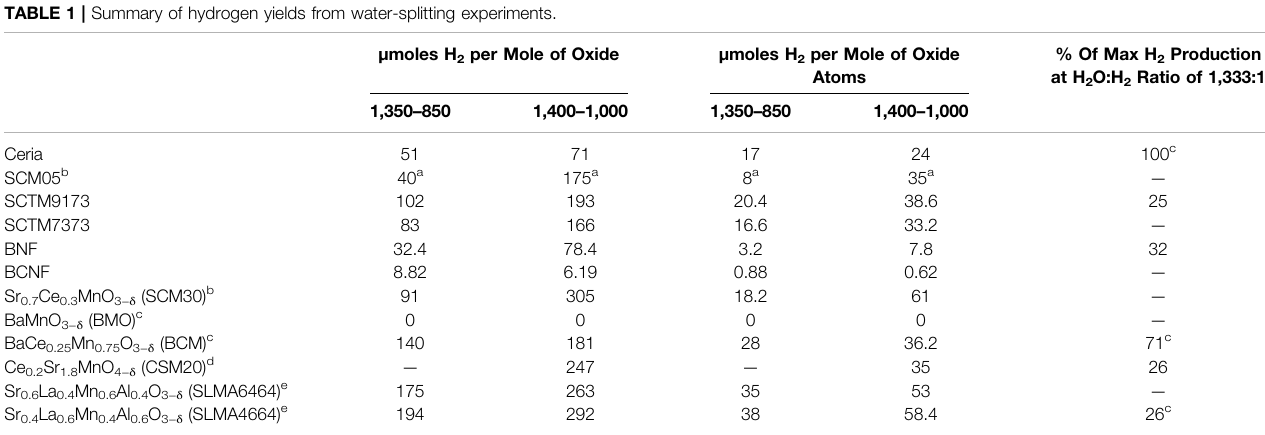
TABLE 1 | Summary of hydrogen yields from water-splitting